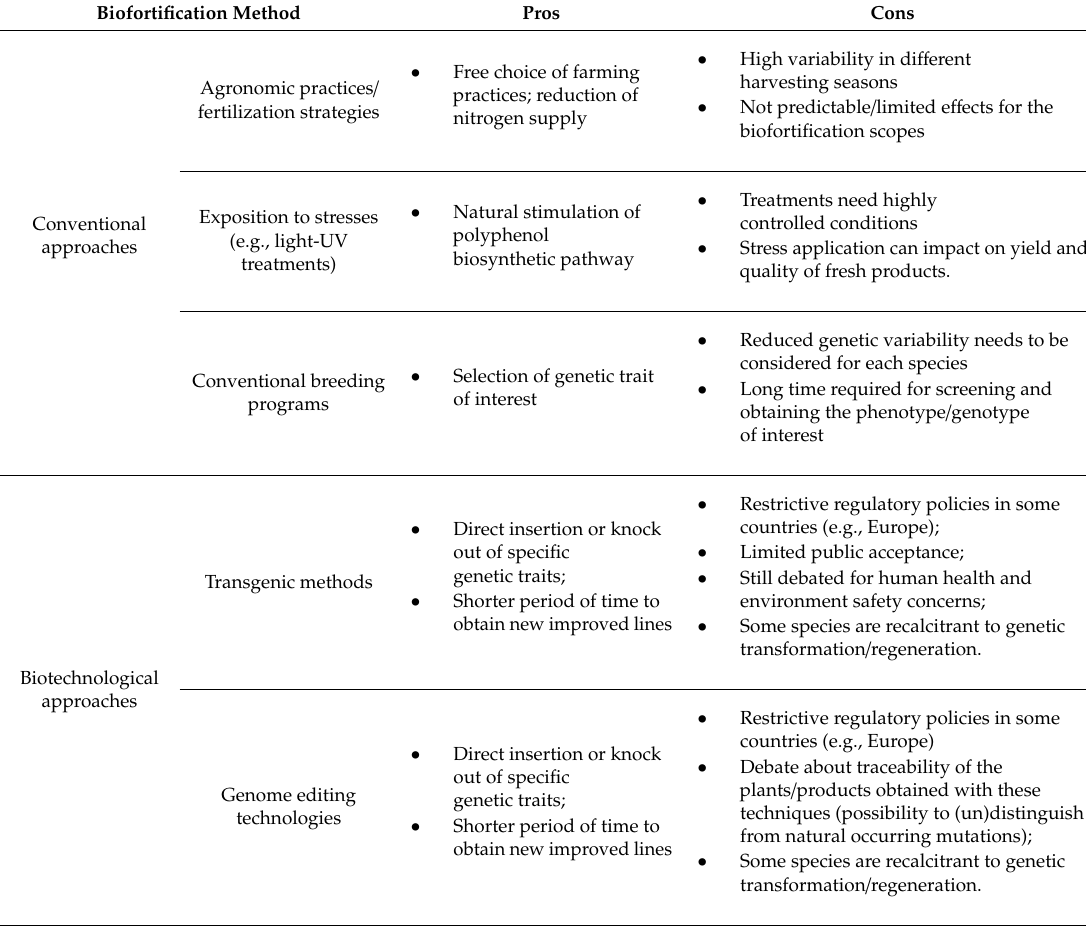
Table 3. Schematic summary of common biofortification methods for the improvement of polyphenol content in plant